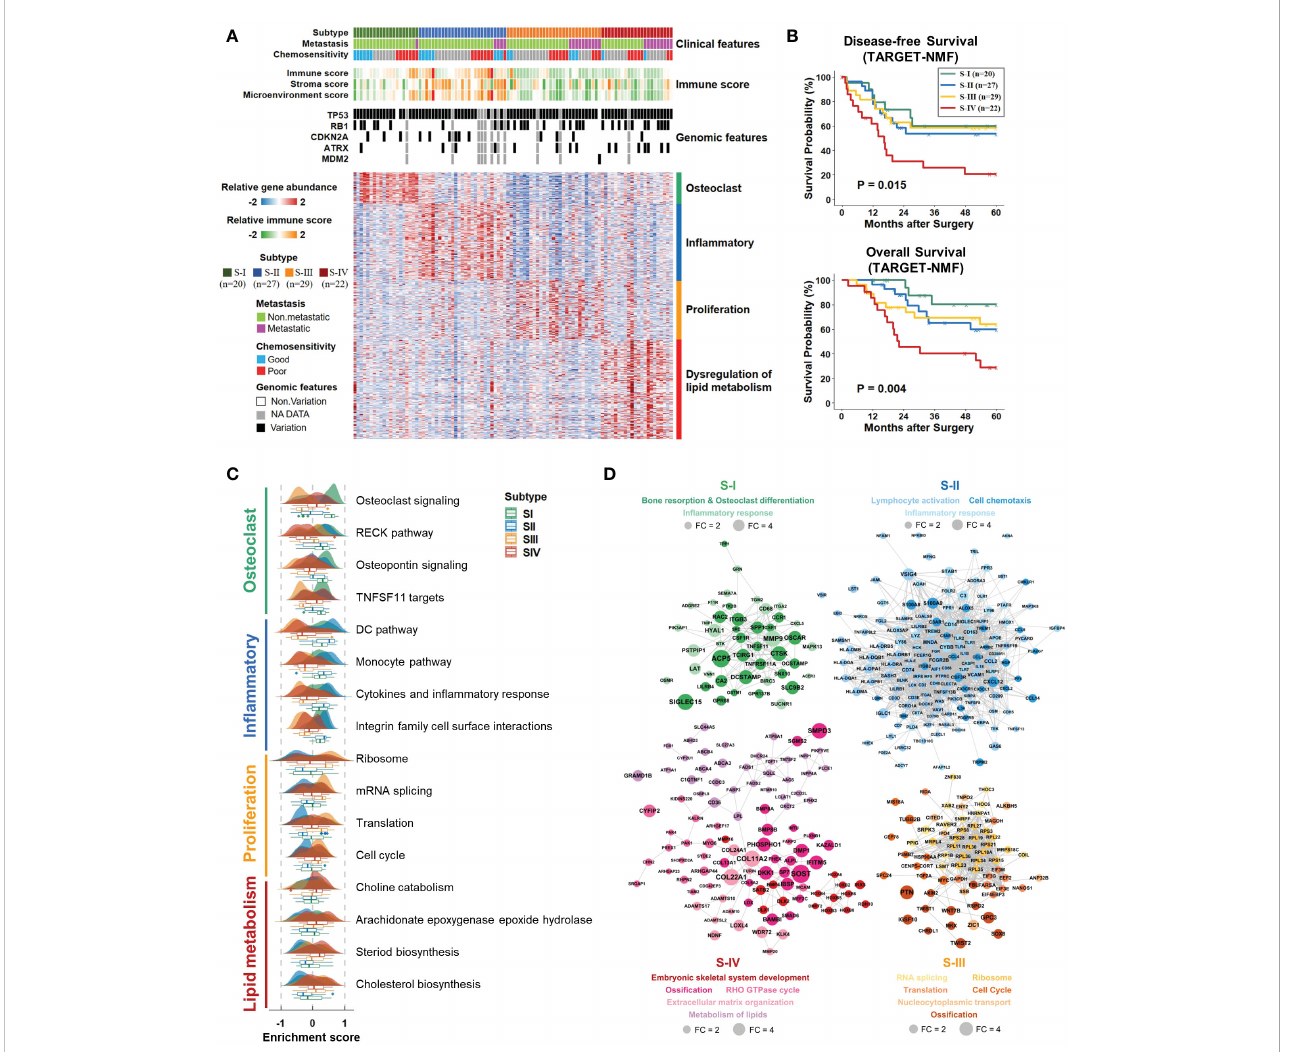
FIGURE 2 Clinicopathologic correlations and functional features of each subtype. (A) Consensus-clustering analysis of transcriptomic pro fi ling identi fi ed four subtypes (Tumor samples, n = 98): S-I (green, n = 20), S-II (blue, n = 27), S-III (yellow, n = 29) and S-IV (red, n=22). Each column indicated a patient sample, and rows represented genes. The associations of subtypes with clinical, immune, and genomic characteristics were annotated in the middle panel. The heat map below depicted the relative abundance of signature genes (log2-transformed). Biological functions were denoted on the right, based on the enrichment of functional pathways. (B) Kaplan – Meier curves of disease-free and overall survival for each subtype in the TARGET cohort. P values were calculated by log-rank test. (C) Ridge and box plots depicted the enrichment of representative GSEA biological pathways in each subtype. (D) PPI network described functional enrichment analyses of DEG (FC>1.5, adjusted p value<0.05). Each dot corresponded to a gene. The dot color represented the subtype, the size fi t the fold-change, and different transparency referred to different functional categories. FC, fold change; GSEA, gene set enrichment analysis; PPI, protein-protein